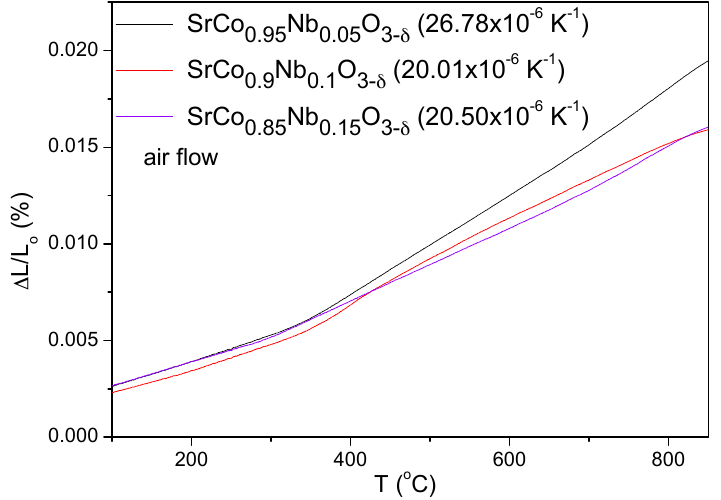
Figure 5. Thermal expansion determined by dilatometry of the SrCo 1 − x Nb x O 3 − δ ( x = 0.05, 0.1, and 0.15) perovskites (data for x = 0.05 are taken from ref. [18], reprinted and adapted from [18], with permission from © 2014 Elsevier).